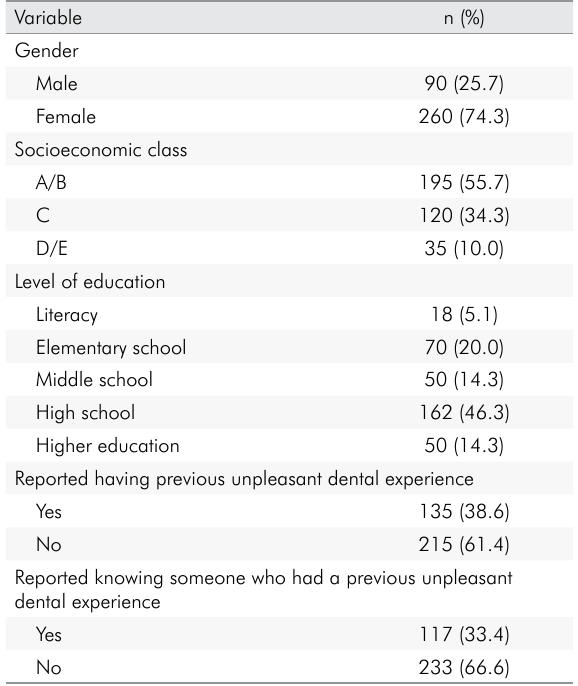
Table 1. Characteristics of the population